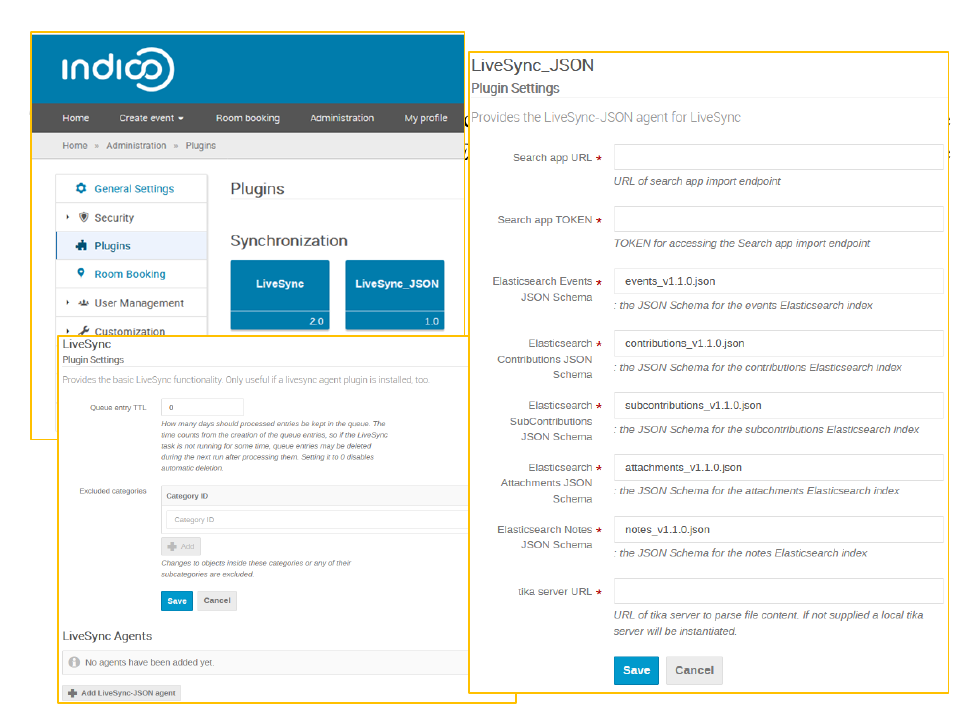
Figure 3. Livesync plugins setup